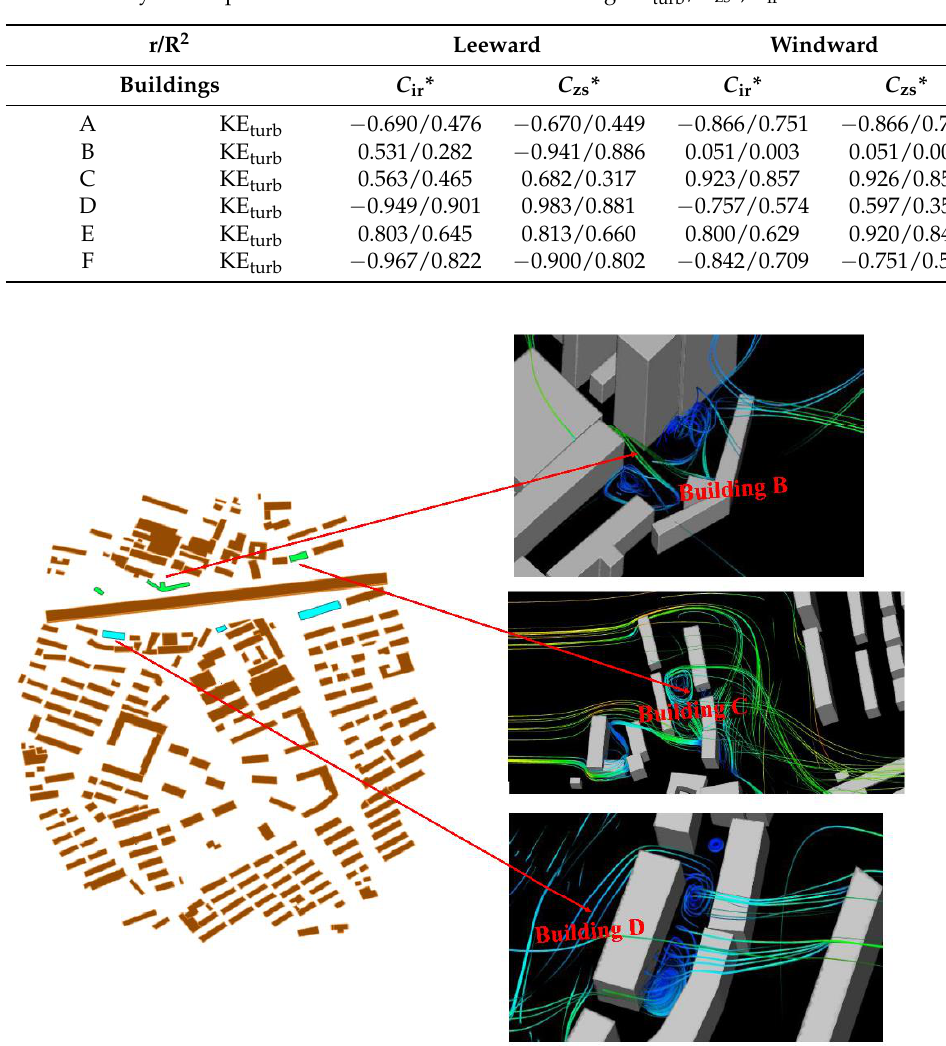
Table 3. Analysis on Spearman correlation coefficients among KE turb / C zs *, C ir *.